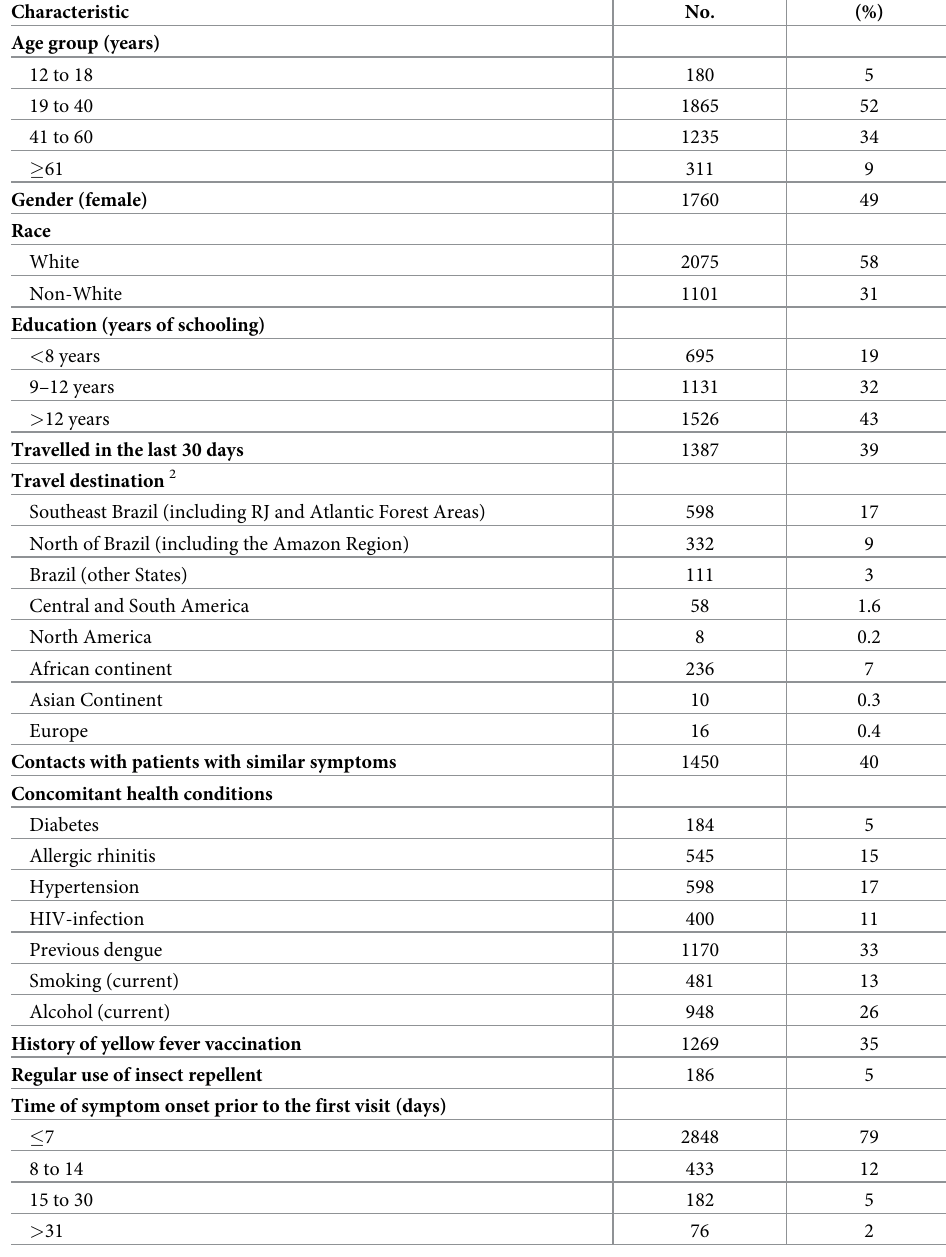
Table 1. Sociodemographic and epidemiologic characteristics of 3591 included patients from the Acute Febrile Illnesses Outpatient Clinic of the Evandro Chagas National Institute of Infectious Diseases, Rio de Janeiro, Brazil. (August 2004—December 2019) 1